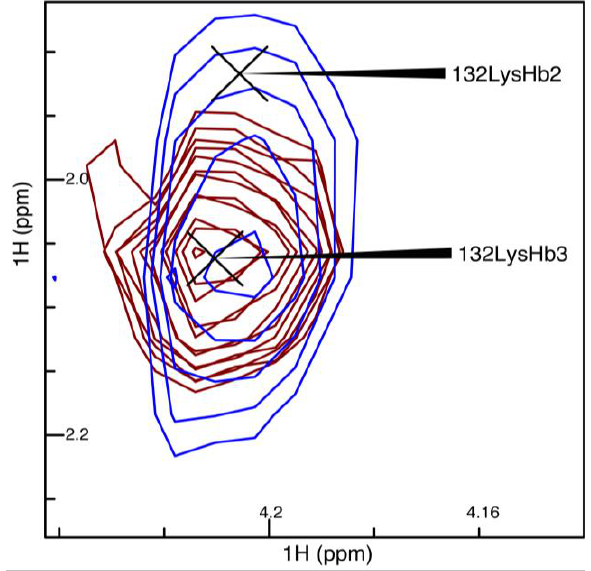
Figure 4. Spectral overlay of linear sampling versus NUS for 3 J Hα–Hβ in blue and red, respectively. Shown are the cross peaks of lysine at position 132 (Lys132). The spectra had a base level normalized to the noise level of the spectra, and had 20 levels with the level multiplier set to 1.2.